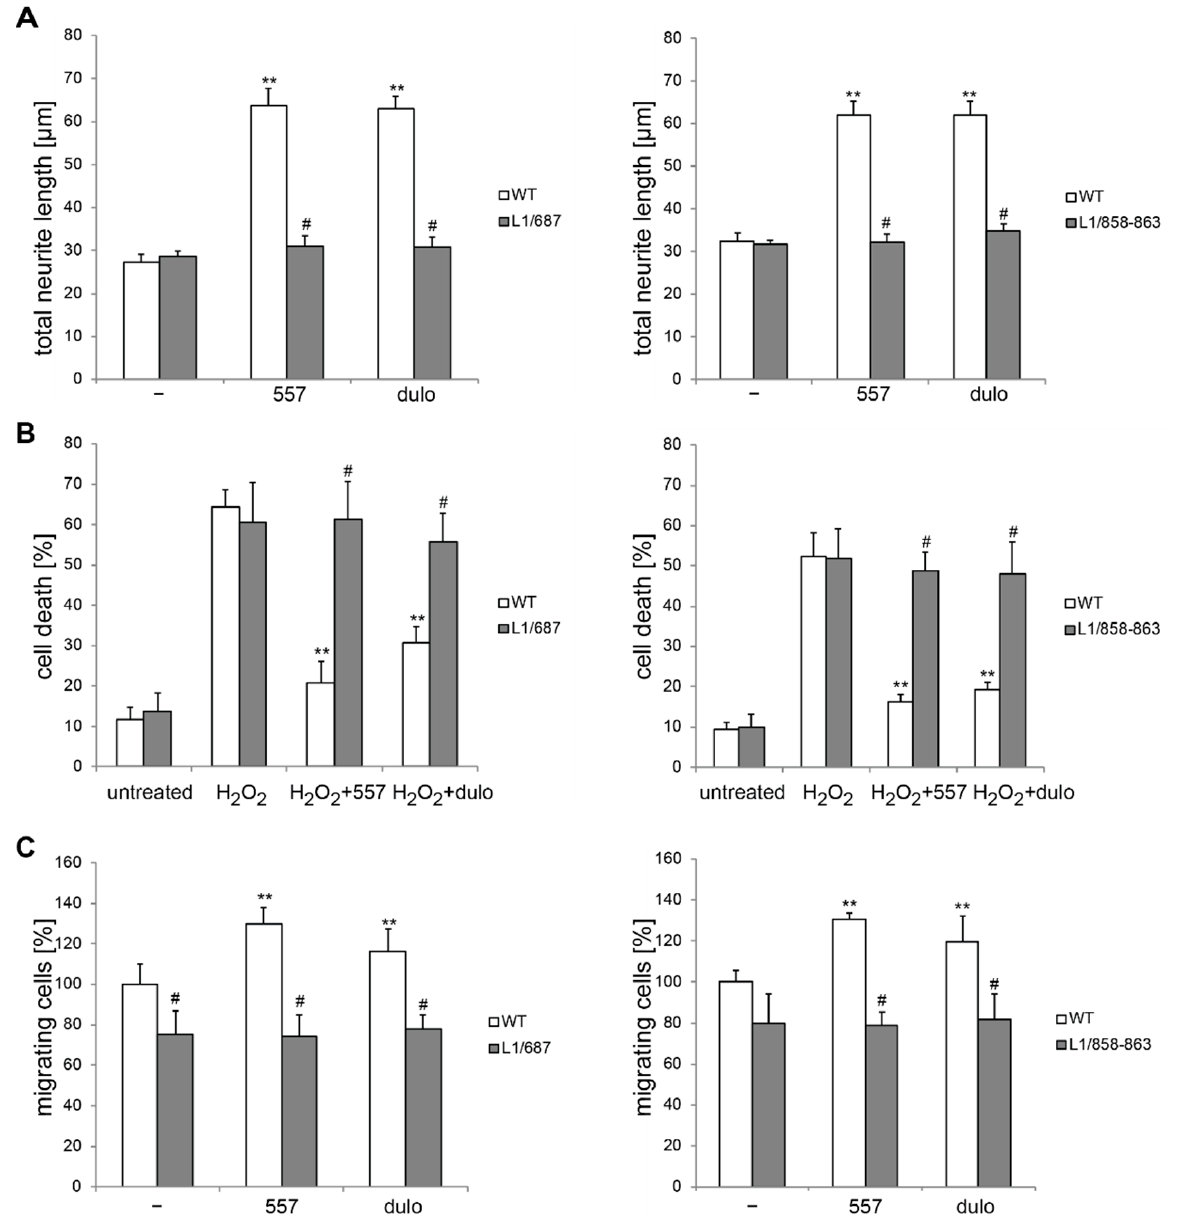
Figure 1. Cerebellar neurons from L1/858–868 and L1/687 mice do not respond to treatment